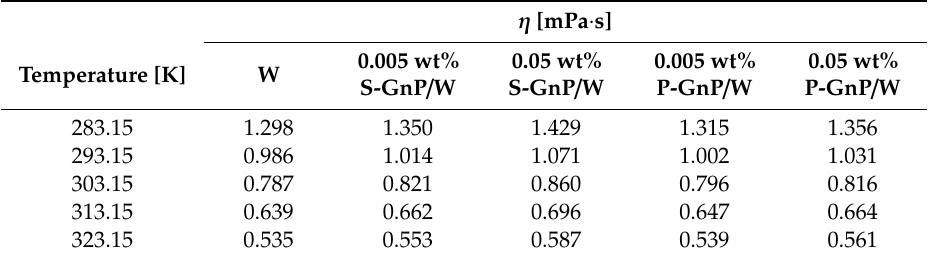
Table 3. Dynamic viscosity values for the different loaded S-GnP and P-GnP nanofluids at temperatures from 283.15 to 323.15 K.